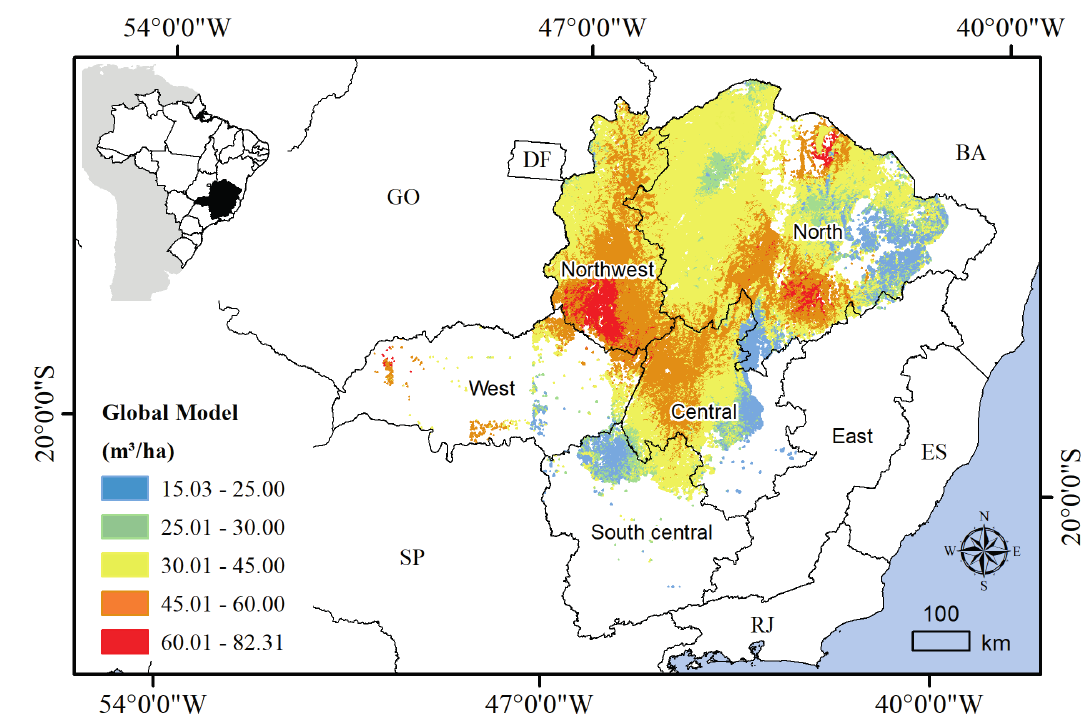
Figure 6 - global model for wood volume (m 3 /ha) for the Cerrado Sensu Stricto in the state of Minas gerais.